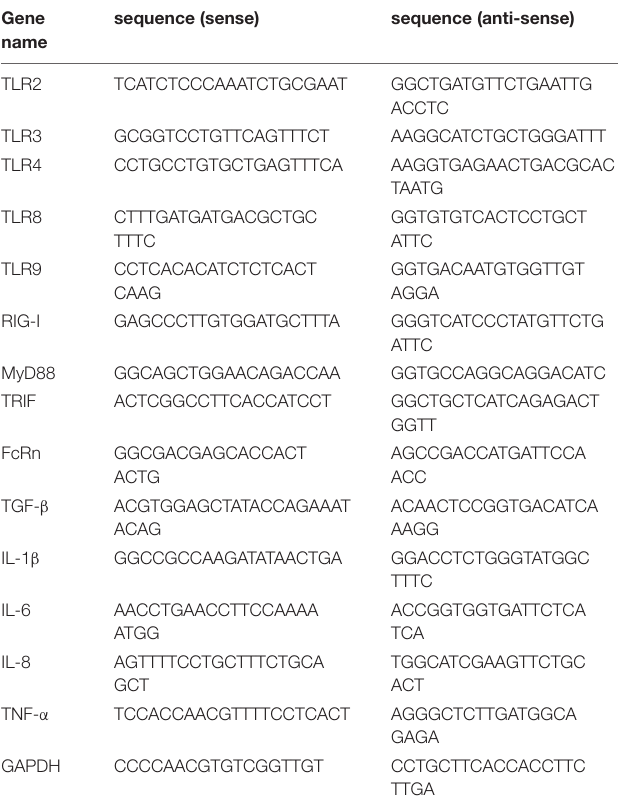
TABLE 4 | Sequences of the primers used for